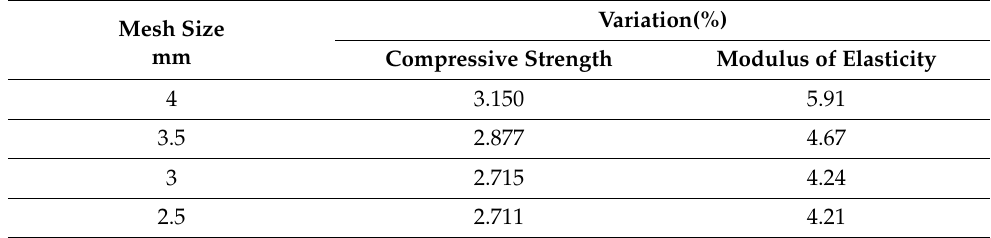
Table 10. Variation of the numerical results, compared to the experimental